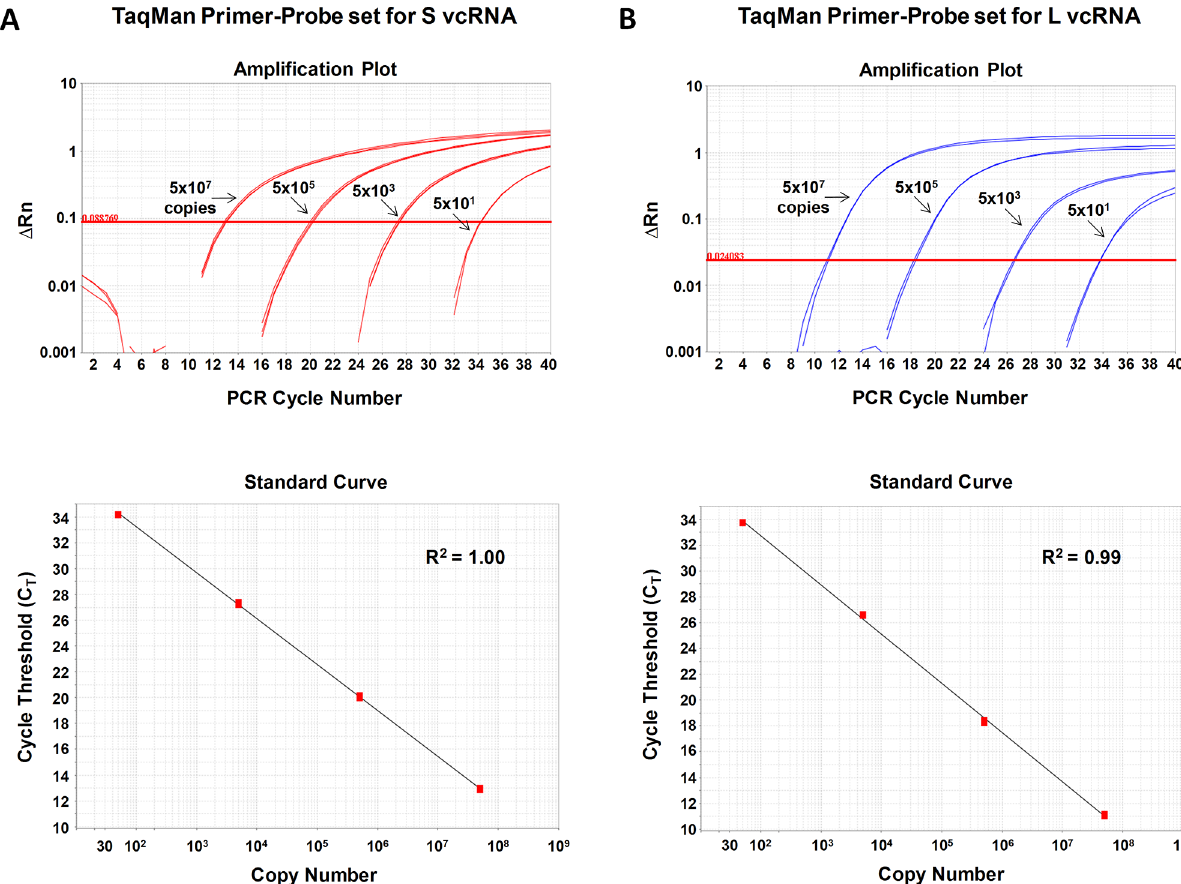
Fig 2. Validation of TaqMan primer-probe sets. Each L or S segment-specific TaqMan primer-probe set was tested for its ability to accurately measure known quantities (50, 5x10 3 , 5x10 5 , or 5x10 7 copies) of a DNA standard control plasmid encoding the target sequence. Depicted are the amplification plots and standard curve fit lines for the primer-probe sets specific for S segment vcRNA (A) or L segment vcRNA (B).